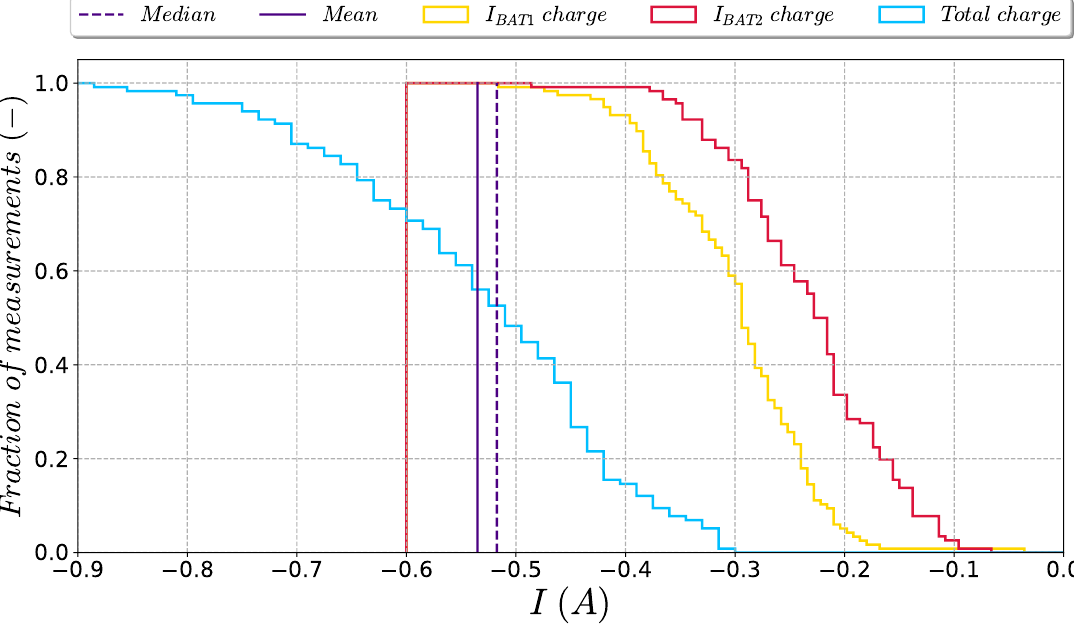
Figure 15. Histogram of the charge currents of both Ten-Koh batteries recorded since the launch. The sum of the two currents, and their mean and median are also shown. Negative current has been defined to be charging the battery. Y-axis reports the fraction of all measurements that saw a current greater than the corresponding X-axis